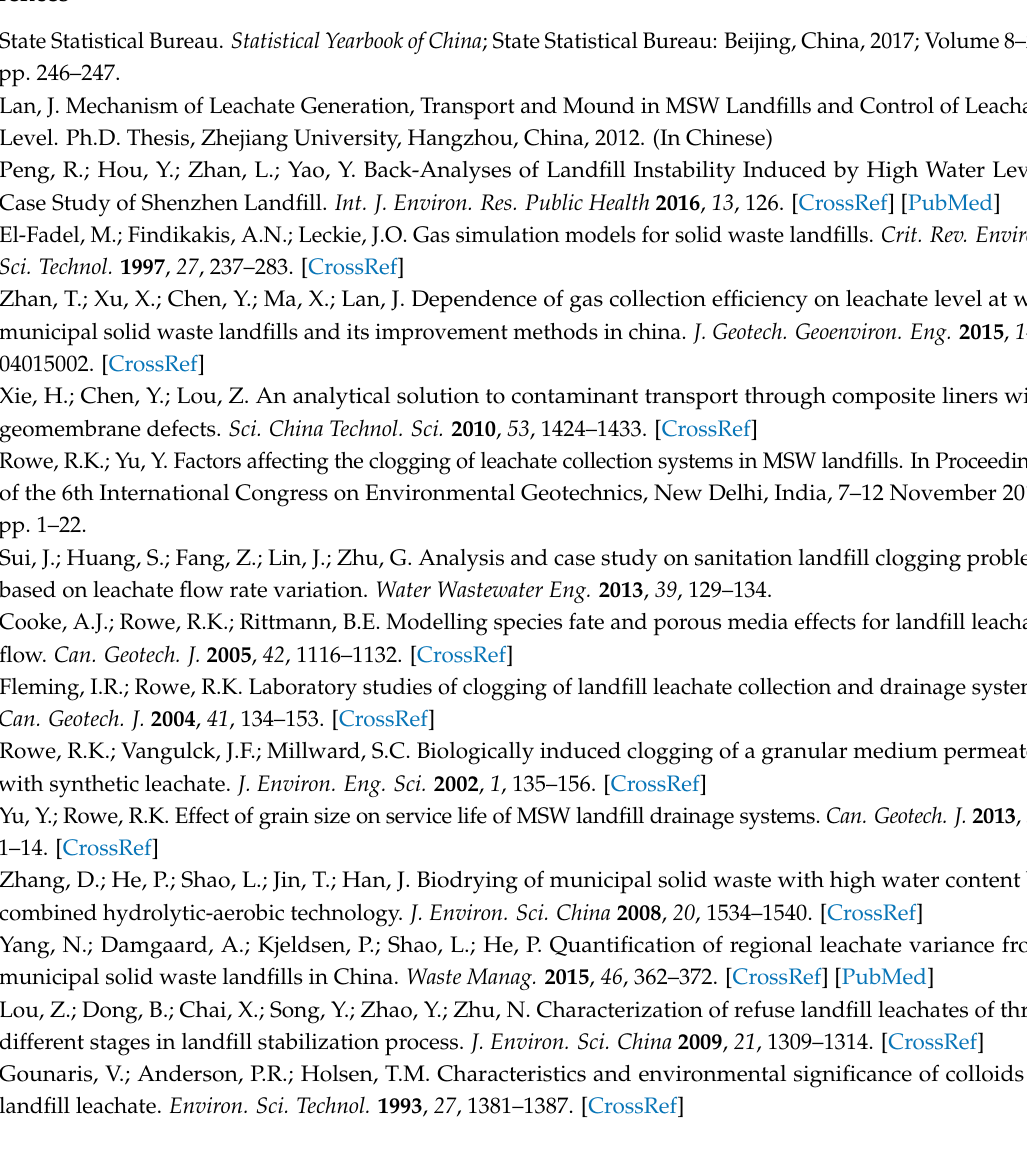
Figure S1: Hydraulic conductivity of geotextile under different filtration fluxes, Table S1: Particle diameter and concentration of each particulate matter size segment, Table S2: List of